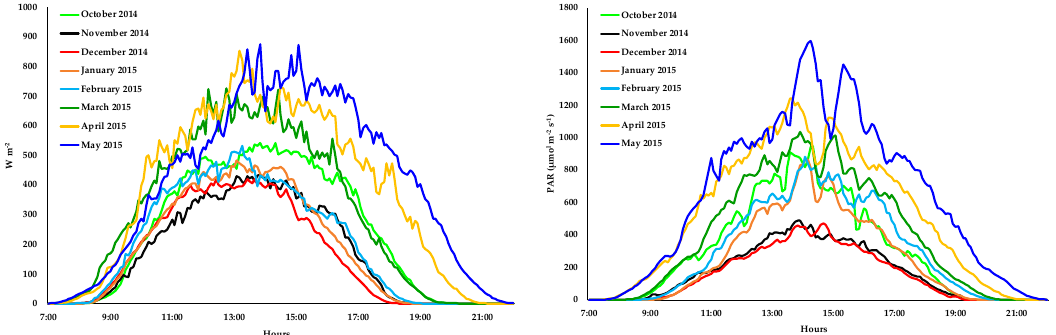
Figure 7. Outside average monthly radiation (W m − 2 ) evolution for the studied period ( left ). Average monthly photosynthetic active radiation (PAR) in the control treatment (0% shade) for the studied period (right).